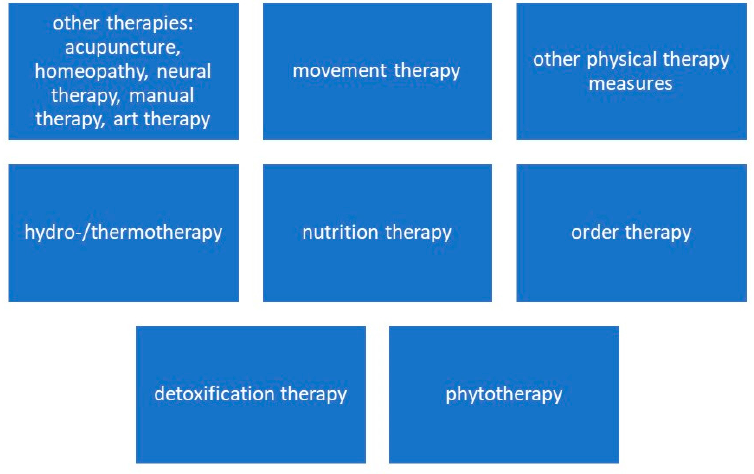
Figure 1. Therapy components of naturopathic complex therapy. The heart rate was measured at five-minute intervals during hyperthermia treatment. The average heart rate during the five hyperthermia treatments was 92.15/min. In the fourth and fifth hyperthermia, the pulse was above the average (Figure 2).